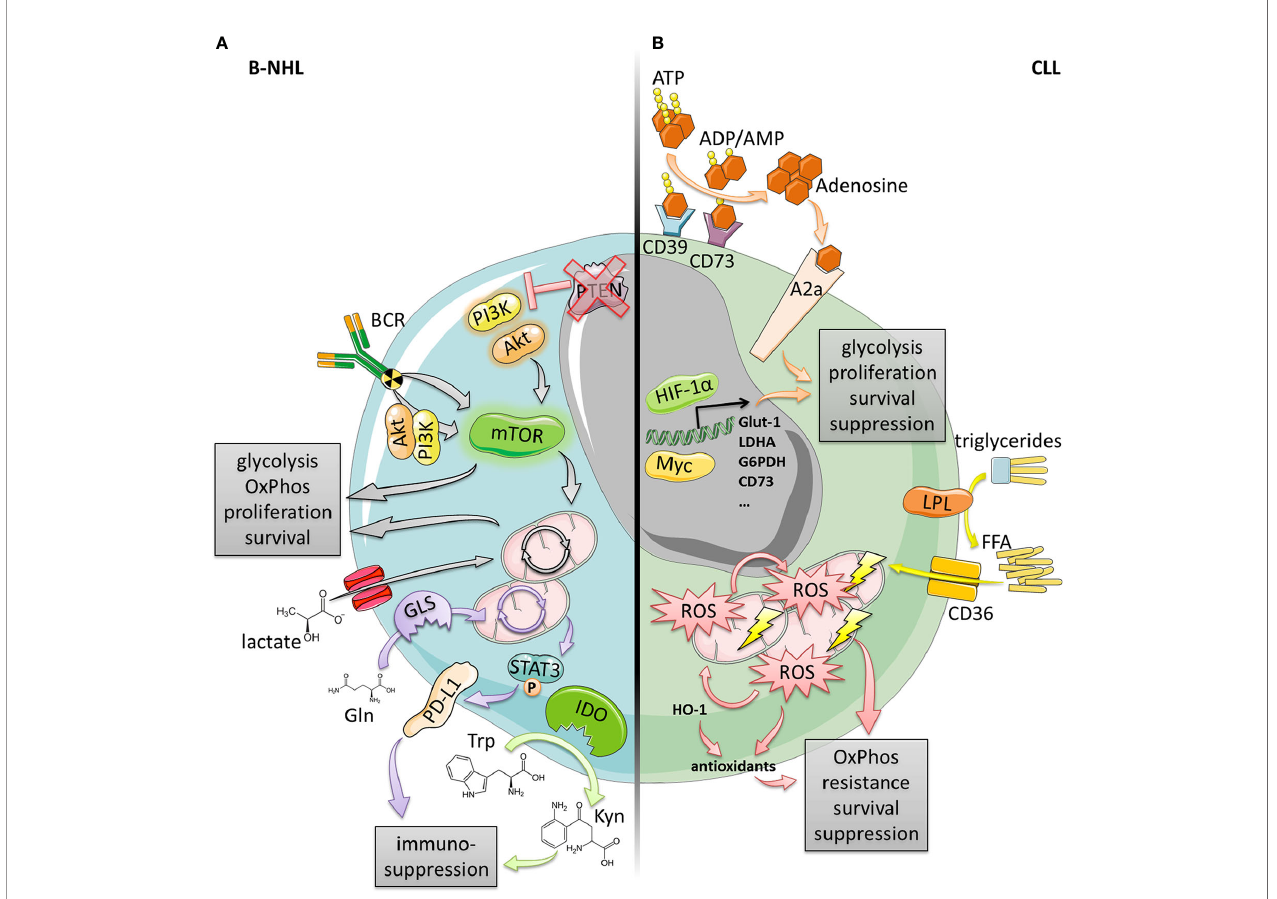
FIGURE 1 | Metabolic alterations in B-cell lymphomas and CLL. (A) B-NHL (DLBCL, MCL, FL) often exhibit an elevated mTOR signaling activity enabling increased glycolysis, OxPhos, proliferation and survival. This can be driven by the BCR in a PI3K/AKT-dependent or independent manner, or by genetic events such as the loss of PTEN expression resulting in constitutively active PI3K/AKT. Increased OxPhos was also found to be fueled by elevated lactate shuttling into the TCA cycle due to increased lactate importer expression. Additionally, both increased expression of IDO as well as glutaminolysis-driven PD ‑ L1 induction provide enhanced immune-suppression. (B) CLL cells display a high mitochondrial biomass and high levels of OxPhos generating large amounts of energy and ROS that in turn drive mitochondrial biogenesis and generation of antioxidants (at least partly by HO-1). This vicious cycle confers enhanced oxidative stress resistance, survival and suppression. OxPhos and mitochondrial biogenesis could also be driven by increased activity of LPL and CD36 consuming triglycerides and importing free fatty acids (FFA). In contrast, microenvironmental trigger (e.g., hypoxia or LN-/BM-stroma) can induce transcription factors, such as Myc or HIF-1 a leading to a glycolytic switch (enabled by high metabolic fl exibility), and an increase of the adenosinergic axis culminating in enhanced survival, proliferation, and